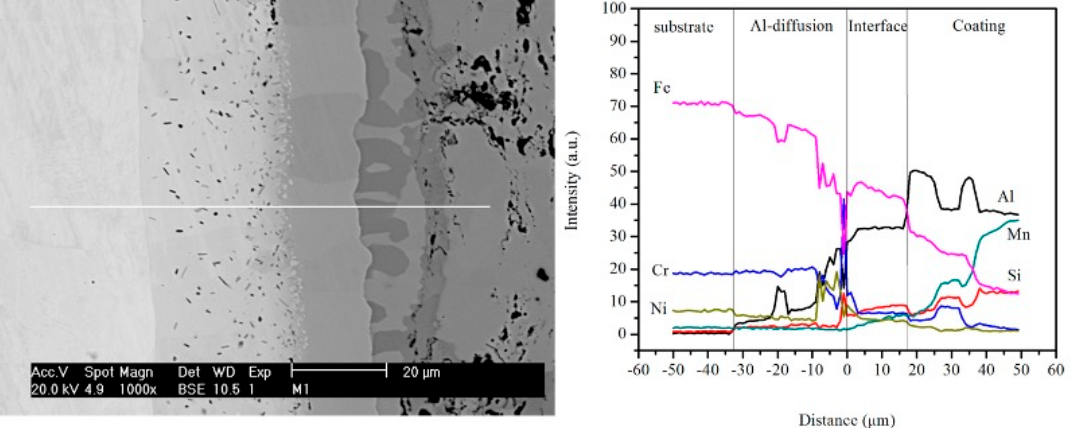
Figure 7. EDS line concentration profiles of a sample processed at 850 °C and 20 MPa for 7200 s.